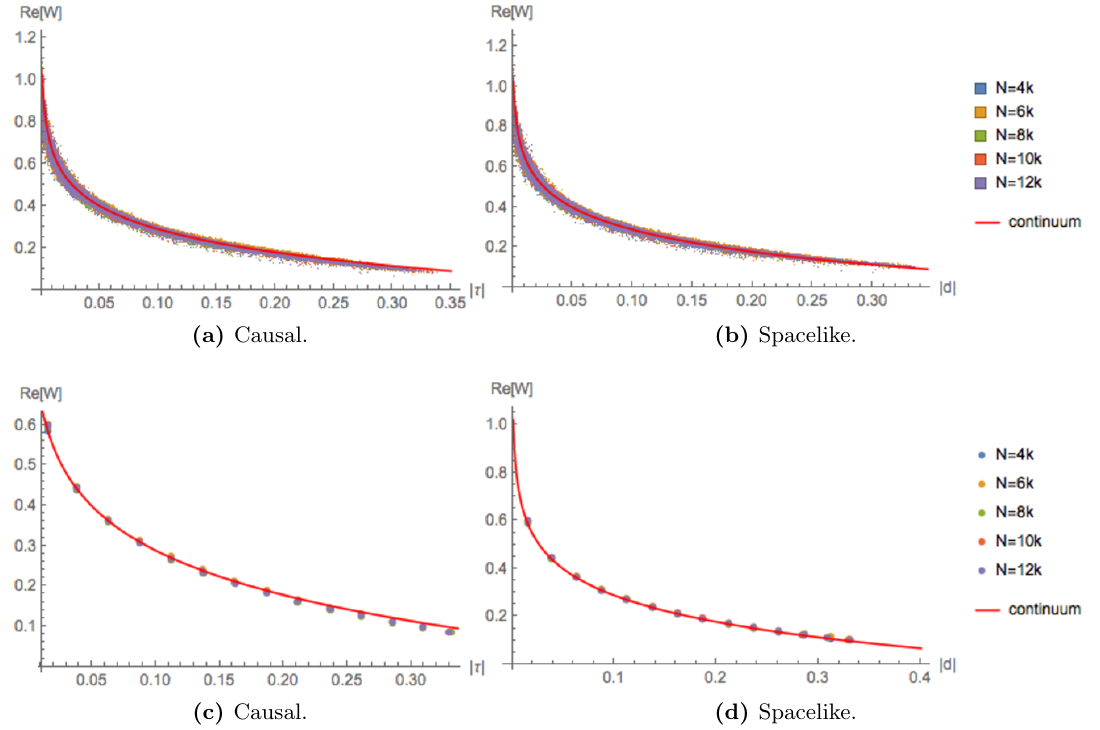
Figure 4. (a)-(b) represent Re[ W ] vs. geodesic distance for all pairs within a sub-diamond with SJ side length 1 = 4 of that the full diamond, in the 2d causal diamond; m = 0. (c)-(d) are plots of the binned and averaged data with the SEM. In both cases, the continuum IR-regulated Minkowski Wightman function (5.1) has also been